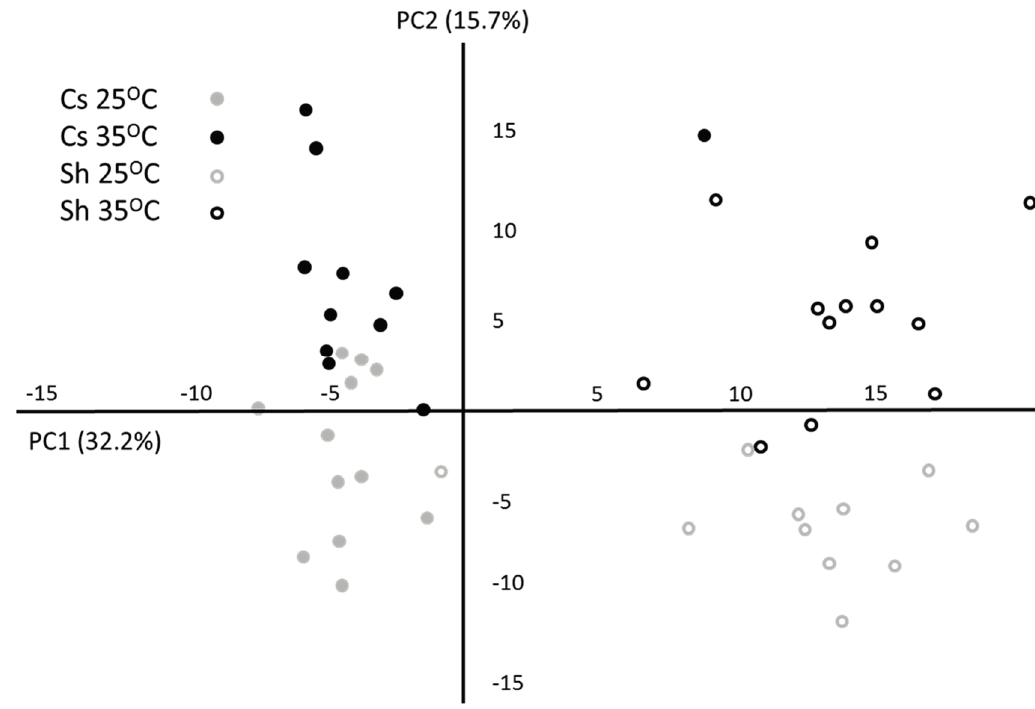
Figure 2. Principal component analysis (PCA) plot ( x —1st component; y —2nd component) of metabolite profiling data from Cabernet Sauvignon (Cs) (full) and Shiraz (Sh) (empty) samples grown at 25 °C (grey) and 35 °C (black)